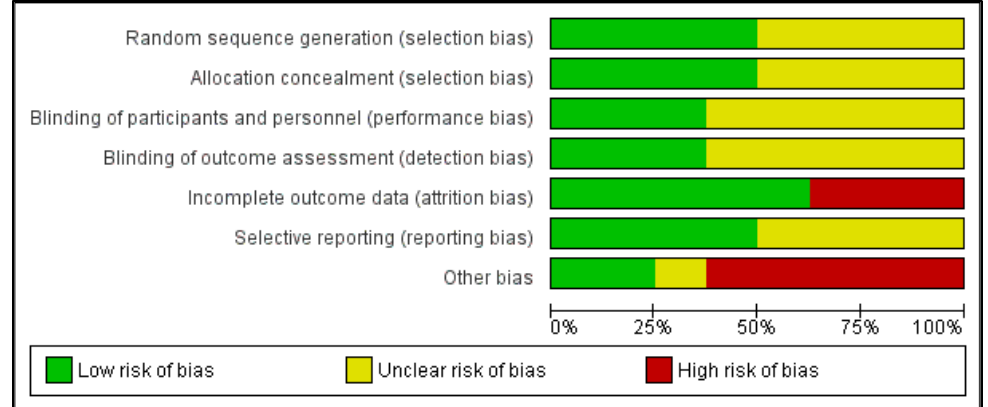
Figure 2. Risk of bias graph.